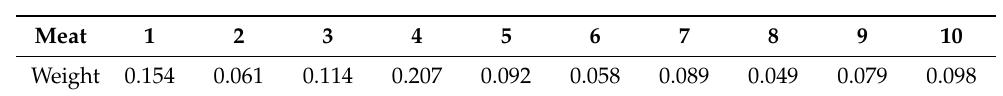
Table A8. Weight of each criterion for